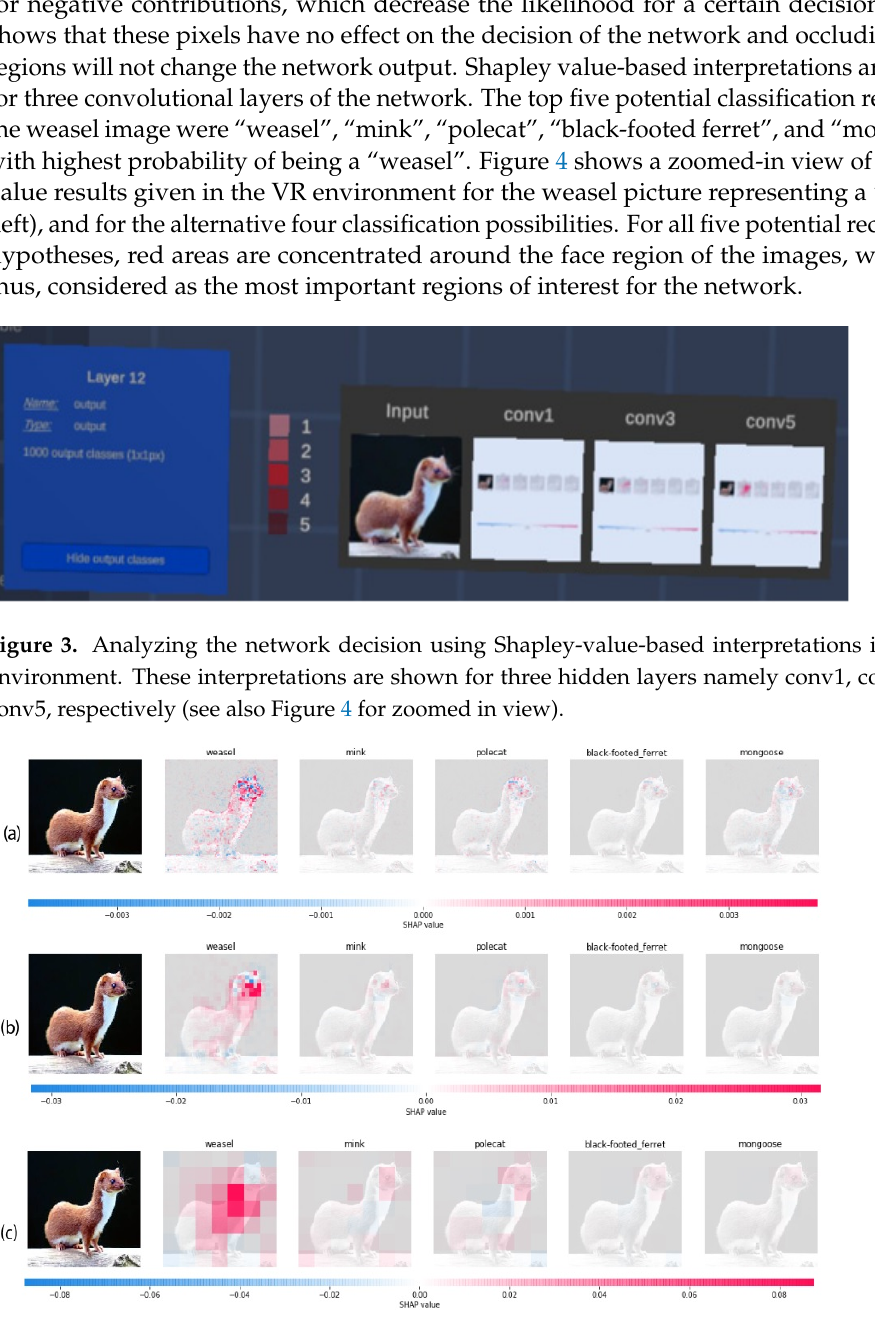
Figure 4. Zoomed in view of VR-based Shapley value results from Figure 3 showing individual interpretation of three hidden layers, ( a ) conv1, ( b ) conv3, and ( c ) conv5 of the weasel image.